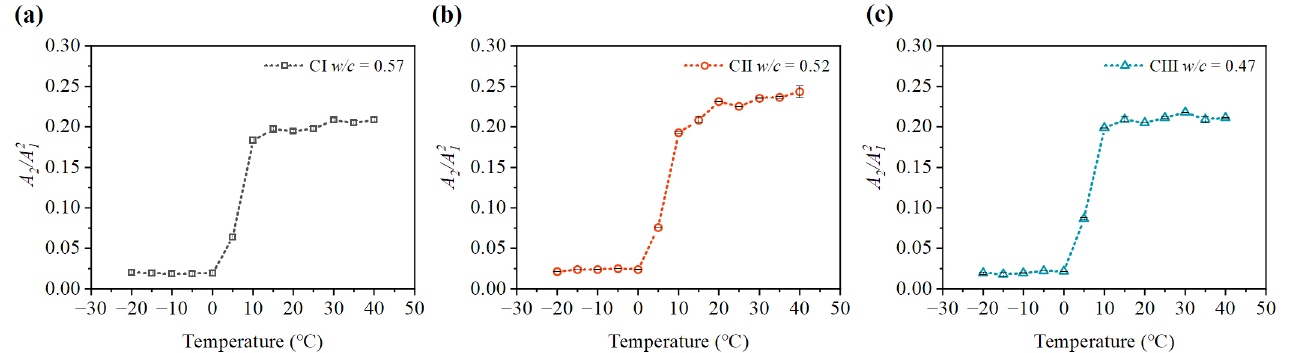
Figure 9. Variation of nonlinear parameter A 2 / A 2 parameter A 2 / A 2 of CI; ( b ) nonlinear parameter A 2 / A 2 1